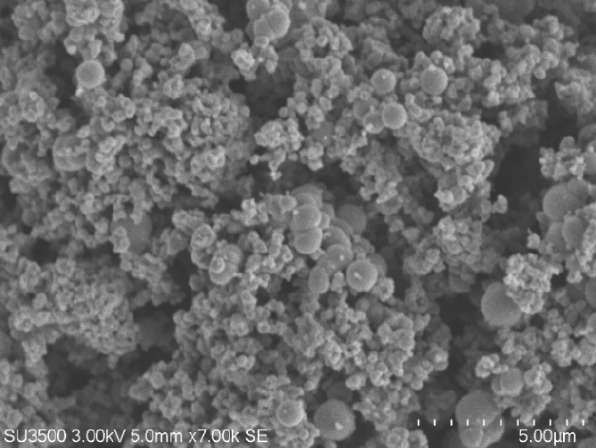
Figure 3. The TiO 2 / SiO 2 composite morphology by scanning electron microscopy (SEM).